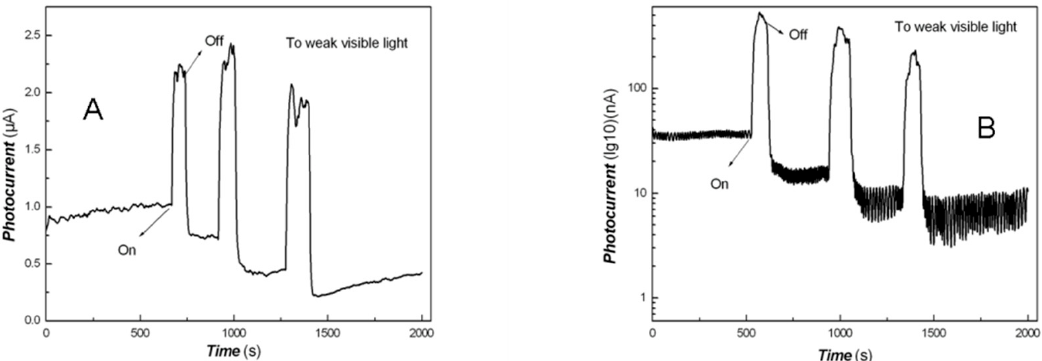
Figure 10. Photo-responses of Au/PANi nanocomposites functionalized with beta-cyclodextrin to weak visible light (A: Sample 2–chloroauric acid (50 mL); B: Sample 3–chloroauric acid (100 mL)). The horizontal axis of Figure 10 is the response time (s). The vertical axis of Figure 8